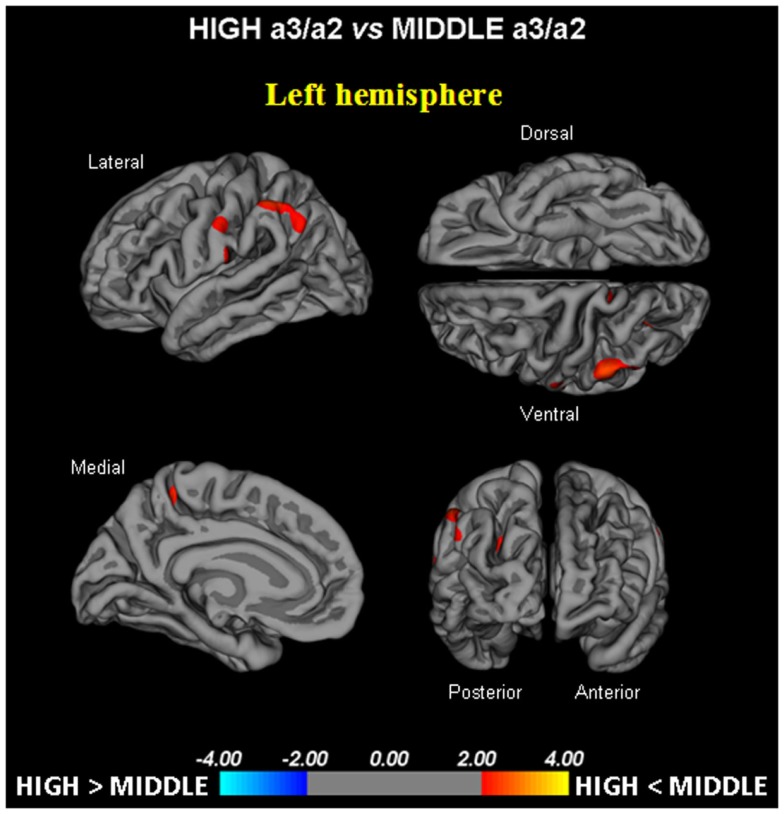
In red are represented the brain regions with higher regional cortical thickness in MCI with high a3/a2 ratio as compared to MCI with middle a3/a2 ratio (p < 0.01 uncorrected). The color-coding for p-values is on a logarithmic scale. Results are presented on the pial cortical surface of brain: dark gray regions represent sulci and light gray regions represent gyri.